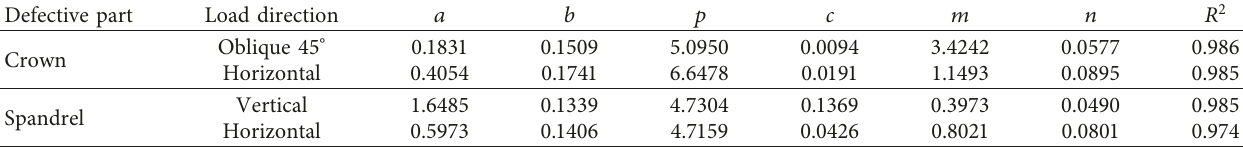
Table 3: Fitting parameters of bearing capacity loss rate of lining under combined